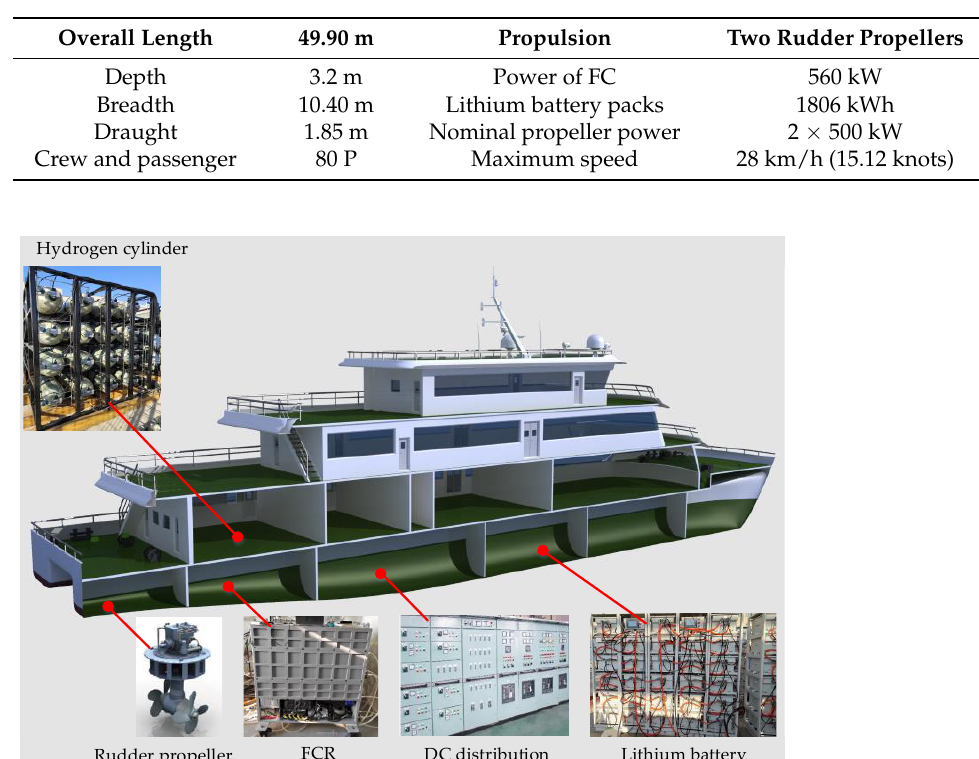
Figure 2. Framework of this study.